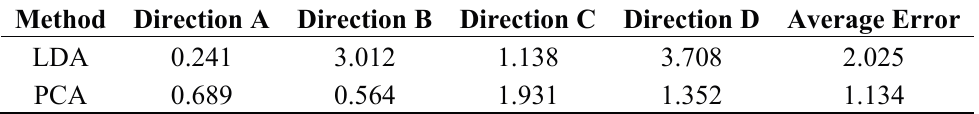
Table 4. Average error rate from two testing sub-databases using LDA and PCA (unit: